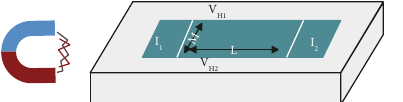
Figure 7: Basic structure of magnetic field